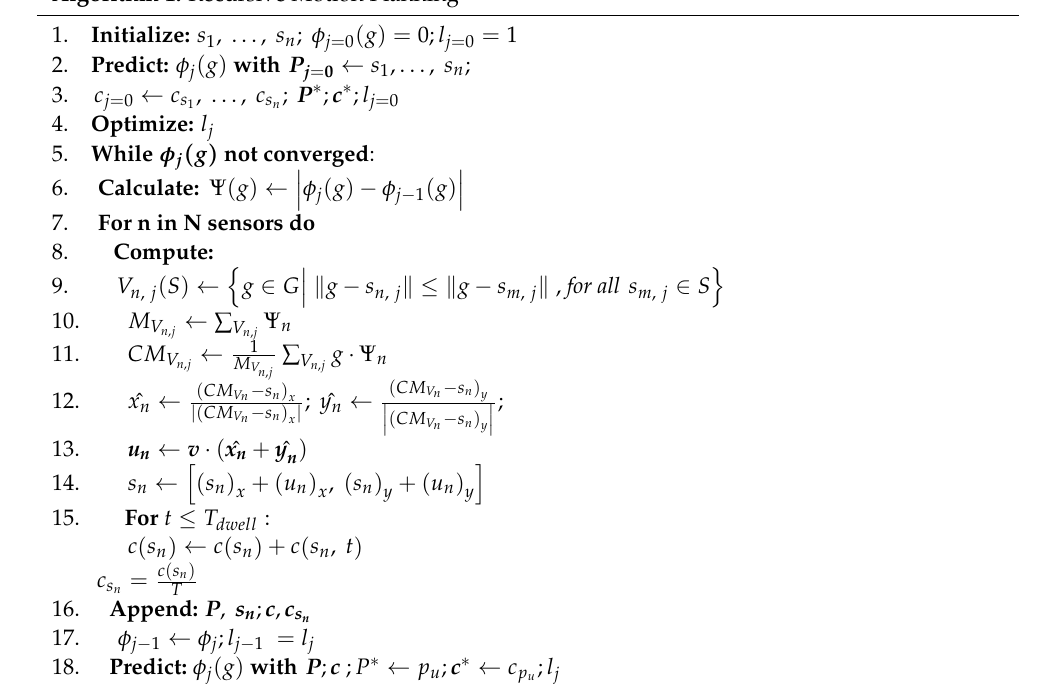
Algorithm 1. Recursive Motion